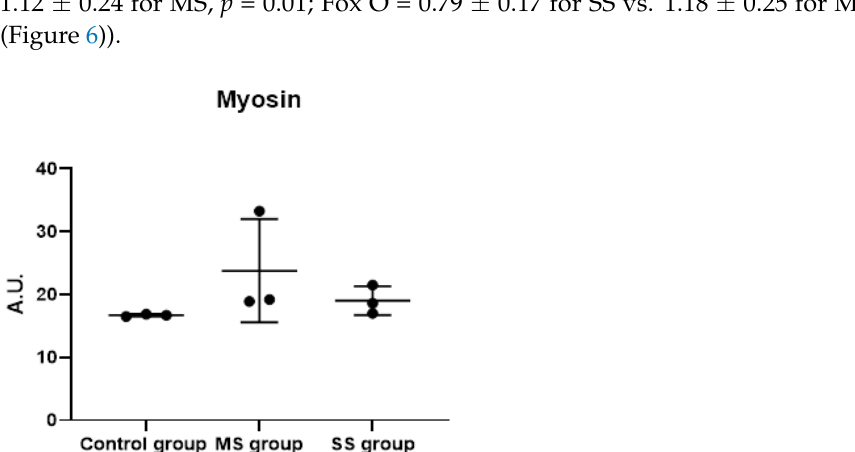
Figure 5. Myosin expression (heavy chain) in human primary myotubes incubated with either a mix of sera from cancer patients with mild or severe sarcopenia or from control participants. Mean ± SD of myosin expression (heavy chain) in myotubes incubated with either a mix of sera from cancer patients with severe sarcopenia (SS group), a mix of sera from cancer patients with mild sarcopenia (MS group), or a mix of sera from the control group. There were no significant differences found. A.U.: absorbance unit. For each condition, n = 2 replicates. The uncropped blots and molecular weight markers are shown in Supplementary Figure S4.